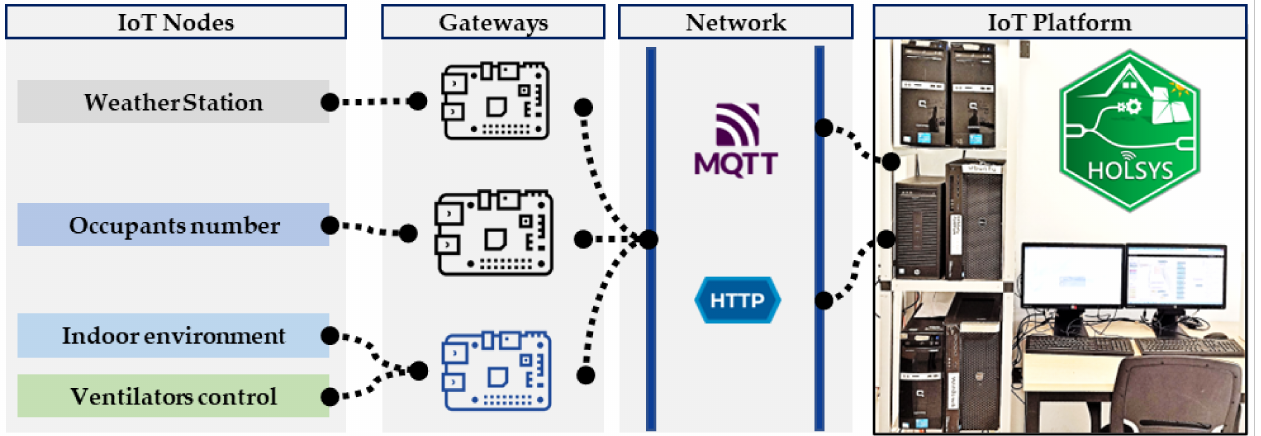
Figure 4. Data transfer from IoT nodes to the HOLSYS platform via RPi gateways over MQTT and HTTP.